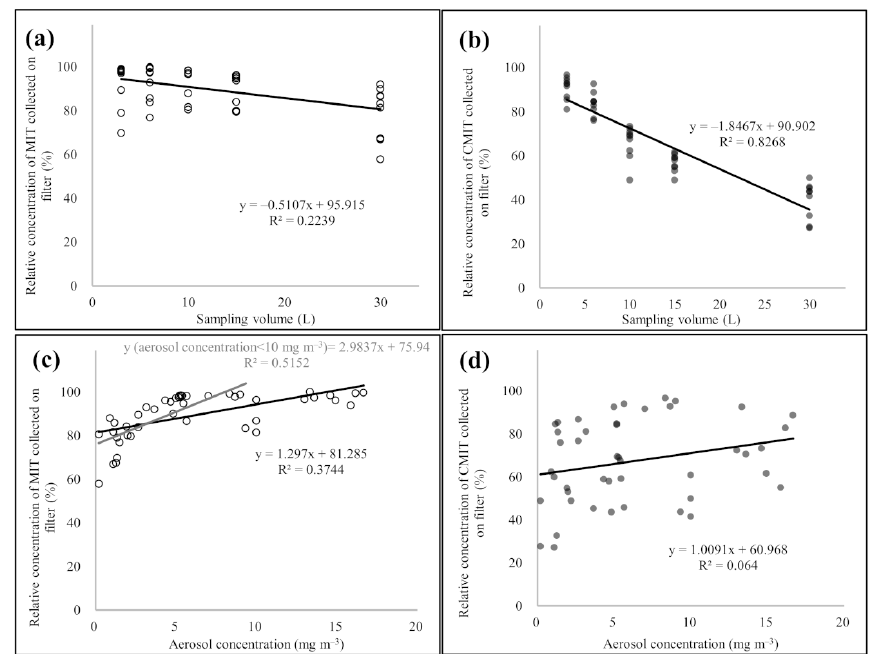
Figure 5. Scatter plot depicting the comparison of the relative concentrations of MIT and CMIT collected on the glass fiber filter with different sampling volumes and the CMIT/MIT aerosol concentrations. ( a ) MIT: relative concentration vs. sampling volume, ( b ) CMIT: relative concentration vs. sampling volume, ( c ) MIT: relative concentration vs. aerosol concentration, and ( d ) CMIT: relative concentration vs. aerosol